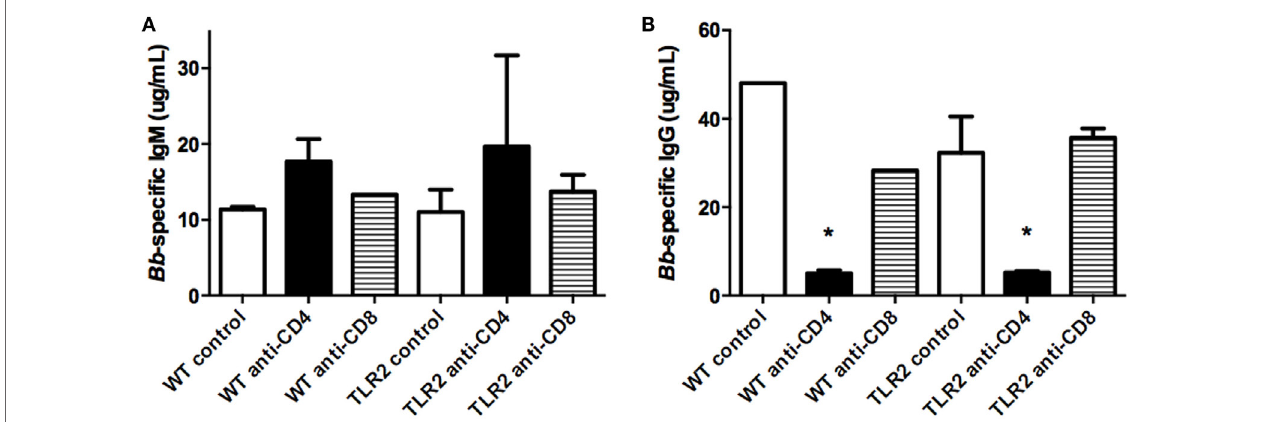
FigUre 6 | Borrelia -specific antibody production . Mice were infected and treated as in Figure 4 . On day 21 postinfection, the mice were sacrificed and assessed for B. burgdorferi -specific IgM (a) and IgG (B) levels in serum. Data are representative of two separate experiments. n = 3, bars represent means ± SD. * p > 0.05 compared to mouse strain